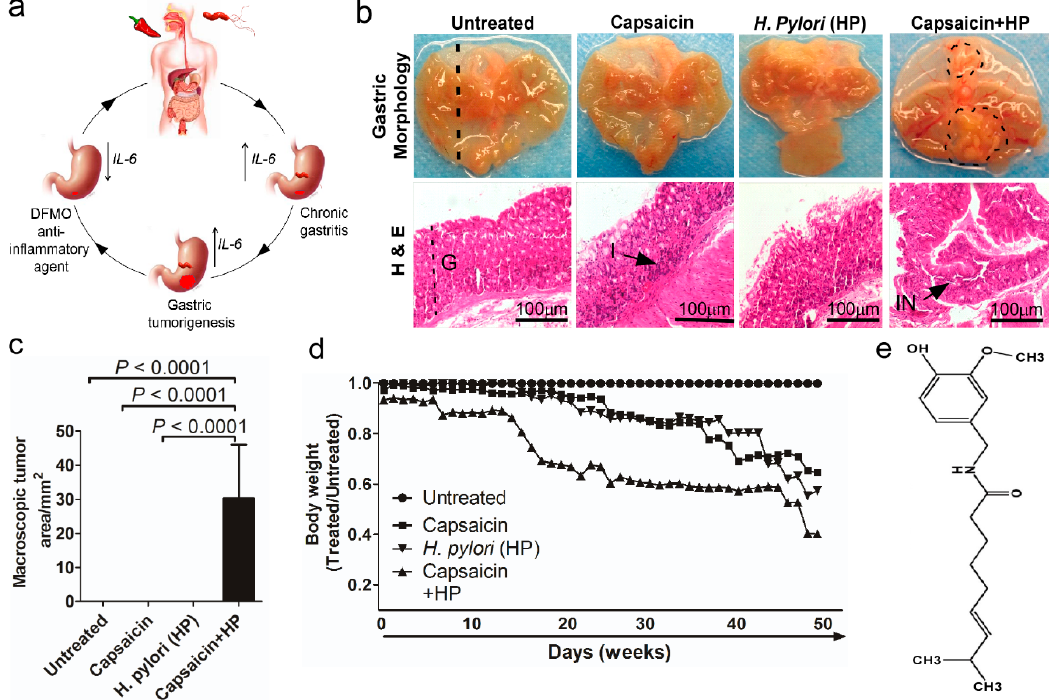
Figure 1. Development of mouse models for capsaicin- and H. pylori -induced progression of gastritis to gastric cancer. ( a ) Schematic drawing showing the effect of capsaicin consumption and H. pylori infection in the development and progression of gastritis to gastric tumorigenesis mediated through the stimulation of IL-6. ( b ) Macroscopic (top) and histologic (bottom) analyses of gastric mucosae ( n = 5 / cohort). Images of tumors at 52 weeks from mice infected with H. pylori and treated with capsaicin; tumor areas are outlined with dotted circles. Hematoxylin & eosin (H&E)-stained cross-sections are cut along the fundus to the proximal end of the corpus, as shown by the straight dotted line. Gastric pathology was substantially changed after 32 or 52 weeks of combination treatment with H. pylori and capsaicin. The panels are magnified 10× (bar, 100 μ m) and 40× (bar , 20 μ m). Arrow and G = glandular zone, I = inflammatory cells, IN = muscular mucosae invasion. ( c ) The size of gastric tumors from mice treated with capsaicin and infected with H. pylori compared to mice treated with only capsaicin or H. pylori is shown. ( d ) Effect of capsaicin, H. pylori, or a combination of capsaicin with H. pylori infection on mouse body weights. Body weights are shown as treated/untreated. ( e ) The chemical structural of capsaicin. Data are expressed as mean values ± SEM, ( n = 5/cohort).